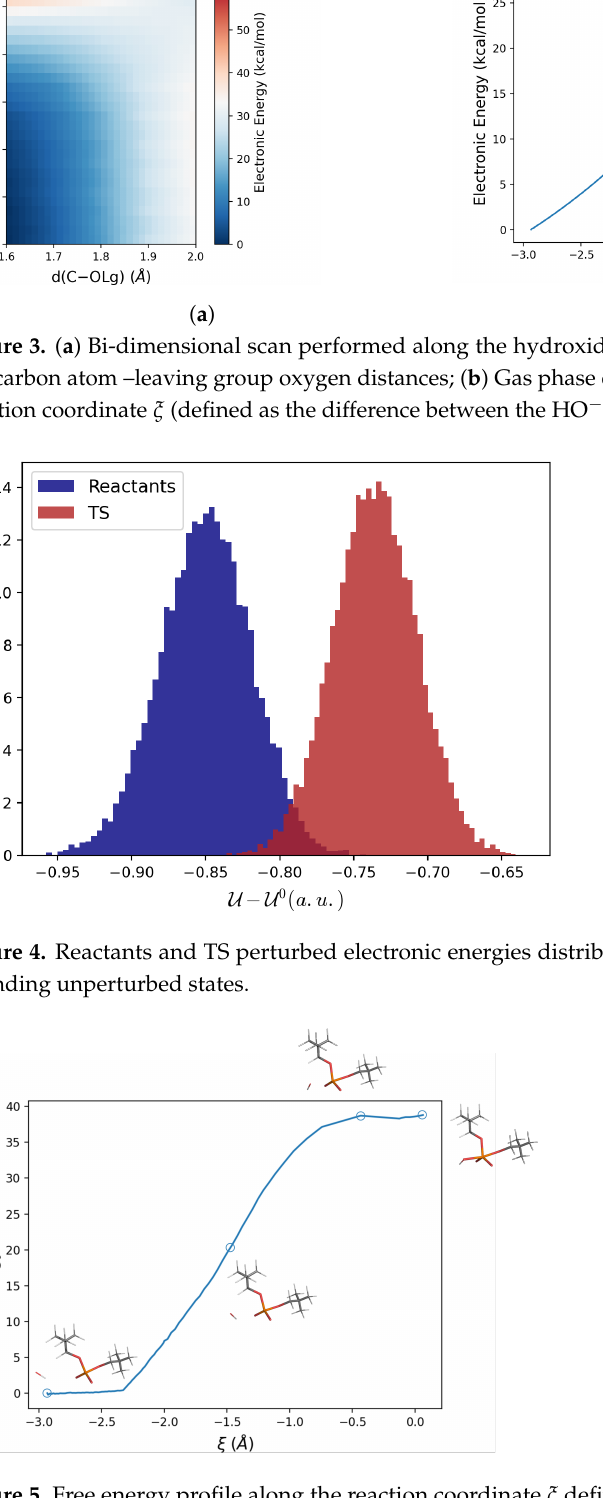
Figure 5. Free energy profile along the reaction coordinate ξ defined as the difference between the HO − –P and the P–OLg distances, for the reaction in aqueous